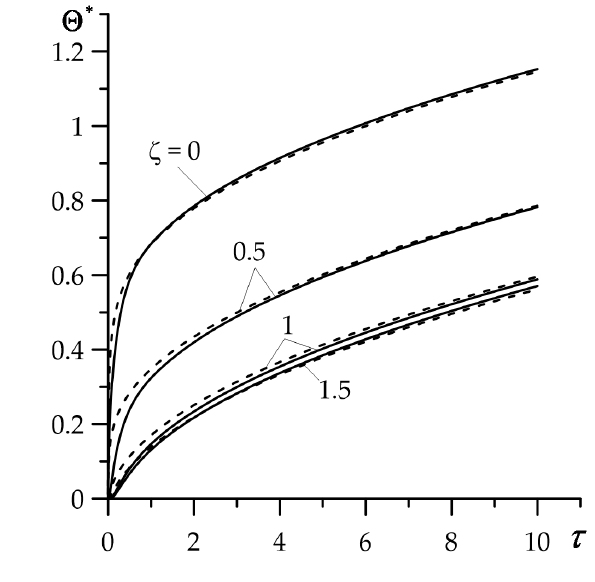
Figure 3. Evolutions of dimensionless temperature rise lines—homogeneous ZrO 2 coating.